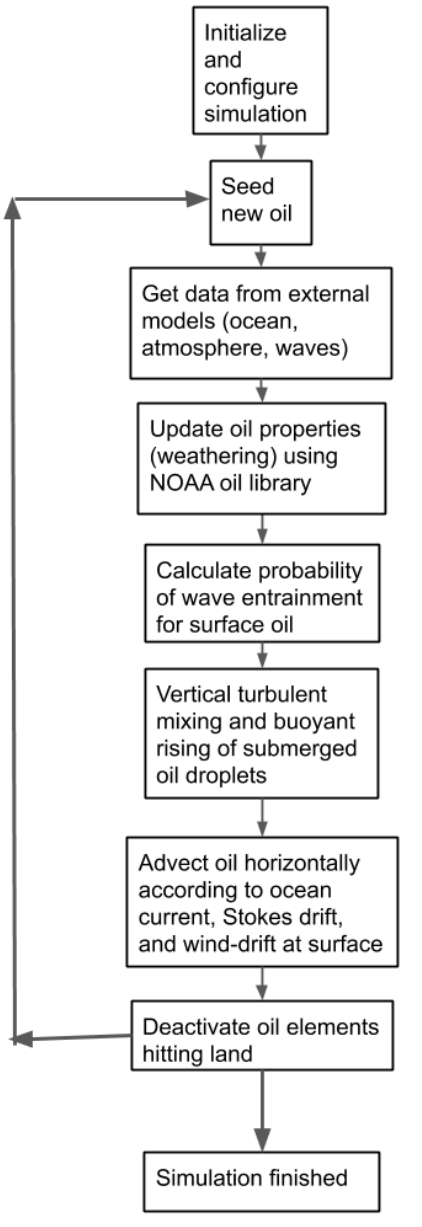
Figure 2. Flow chart showing the sequence of operations involved in the OpenOil